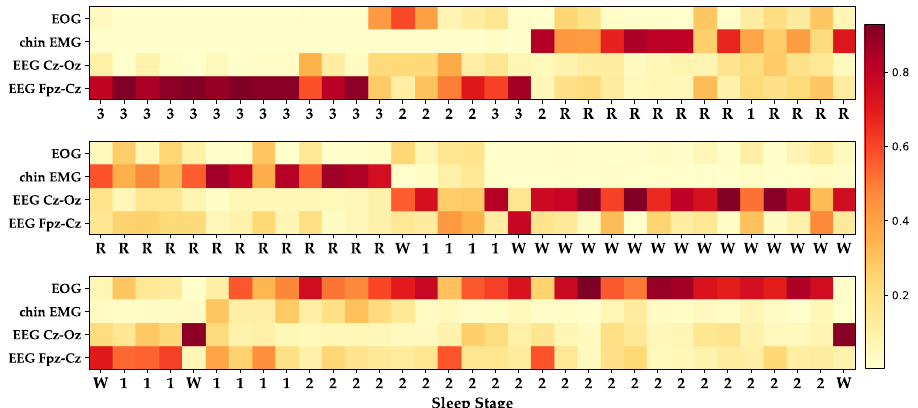
Figure 9. Attention weights for each channel in stage sequence, which W, 1, 2, 3, R refer to Wake, N1, N2, N3, and REM.